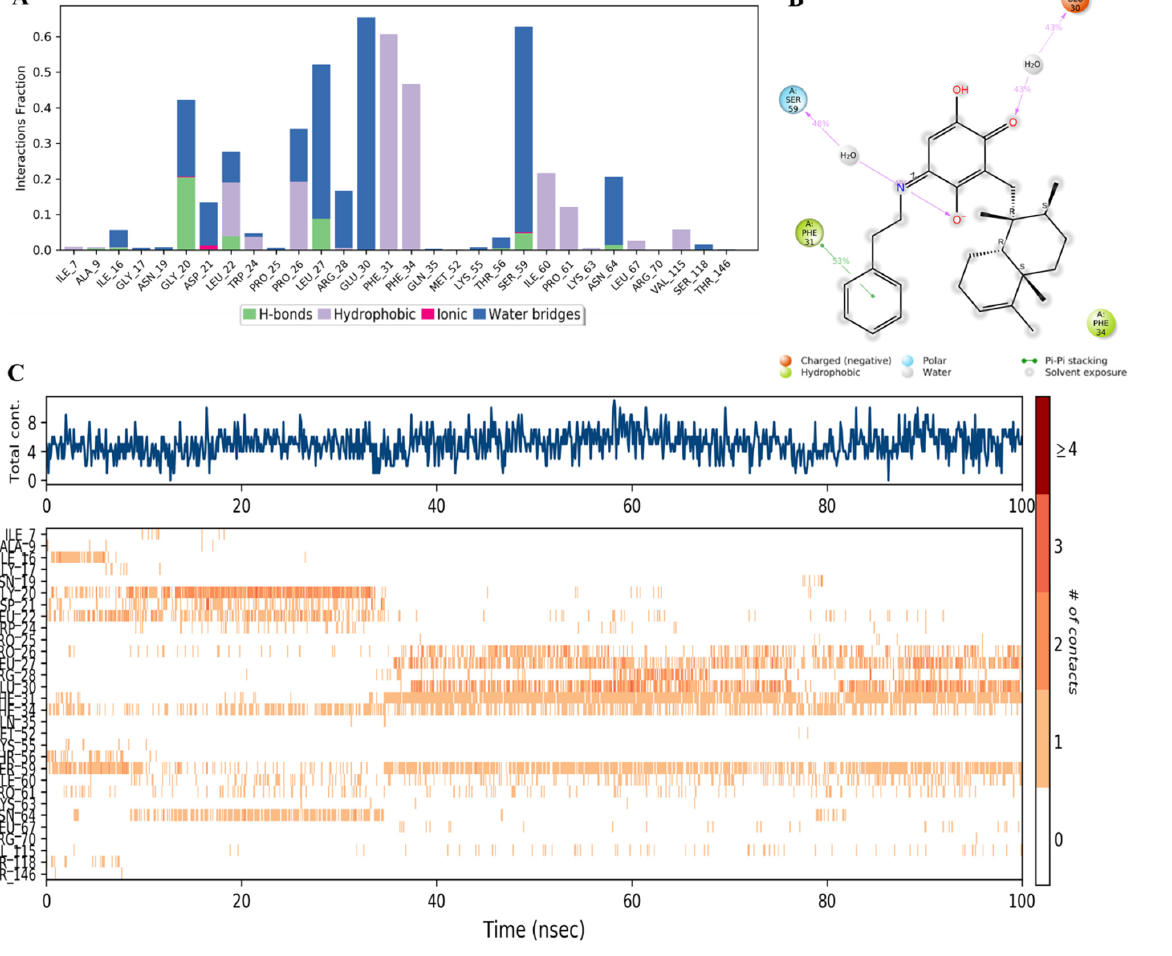
Figure 18. ( A ) Stacked bar graph of hDHFR (PDB: 1KMV) interactions with compound 44 throughout the simulation. The values were normalized over the course of the trajectory. ( B ) A diagram illustrating the detailed connections of 44 with hDHFR. The coordination that appears at least 30% of the designated time period (0.00 to 100.00 nsec) will be presented. It is possible to observe more than 100% as some residues might be linked to the same ligand atom more than once; the pink colored arrows represent the hydrogen bond interaction while the % on the arrows represent the coordination % during the simulation time. ( C ) Timeline of hDRFR- 44 interactions is presented in ( A ). The top panel presents the total number of specific interactions the protein made with the ligand over the course of the trajectory. The bottom panel presents the residues interacting with the ligand in each trajectory frame. The dark orange color indicates more than one specific interaction is made between some residues and the ligand. As the orange color becomes lighter, the number of contacts between the residue and ligand decreases. The white color indicates no interaction is formed.